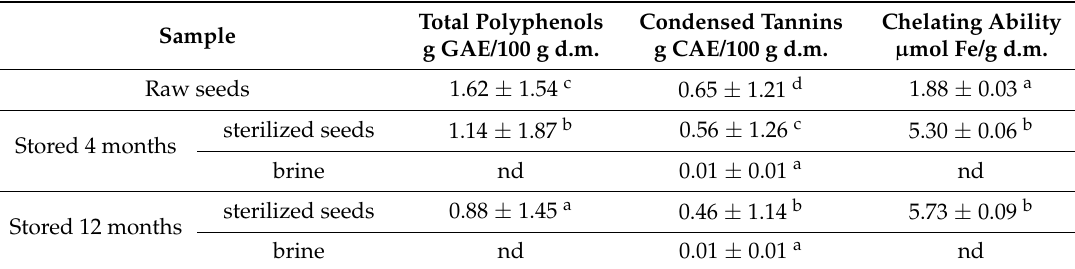
Values are mean ± SD. Data with the same superscript alphabets in columns are not significantly